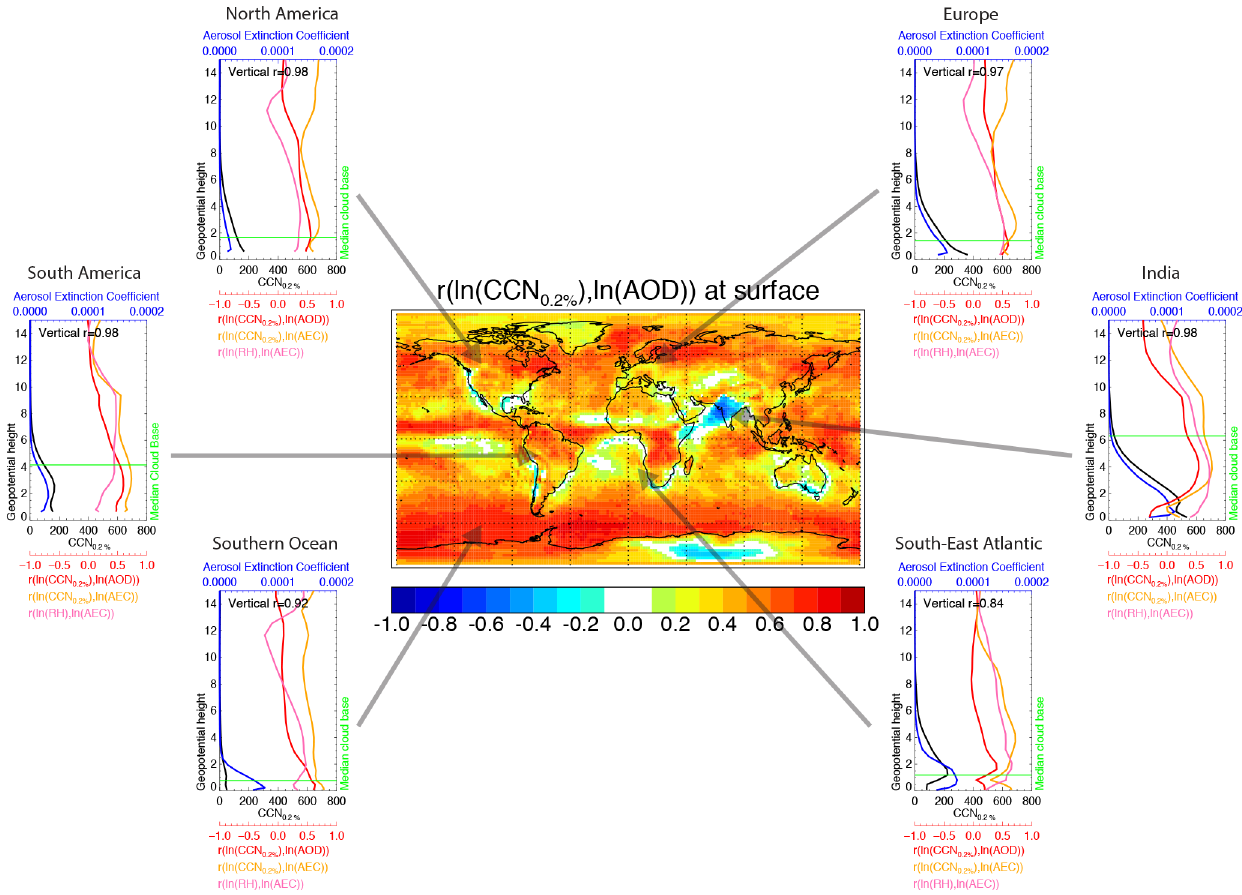
Figure 6. Map of Pearson’s correlation coefficient r of ECHAM-HAM simulated surface ln ( CCN 0 . 2% ) with column-integrated aerosol optical depth ln ( AOD ) calculated for each model grid box from 1year of 6 hourly pairs. Annual-mean vertical profiles of CCN 0 . 2% (cm − 3 ) (black), aerosol extinction coefficient (AEC) (m − 1 ) (blue), profile of temporal correlation of ln ( CCN 0 . 2% ) with column-integrated ln ( AOD ) (red), profile of temporal correlation ofln ( CCN 0 . 2% ) with vertically resolved extinction coefficient ln ( AEC ) orange) and temporal correlation of ln ( RH ) with vertically resolved extinction coefficient ln ( AEC ) (pink). Also shown is the model median stratiform cloud base for each region (green) – note that this corresponds to the lowest detrainment level in regions dominated by convection, such as India. Regions defined as in Fig.